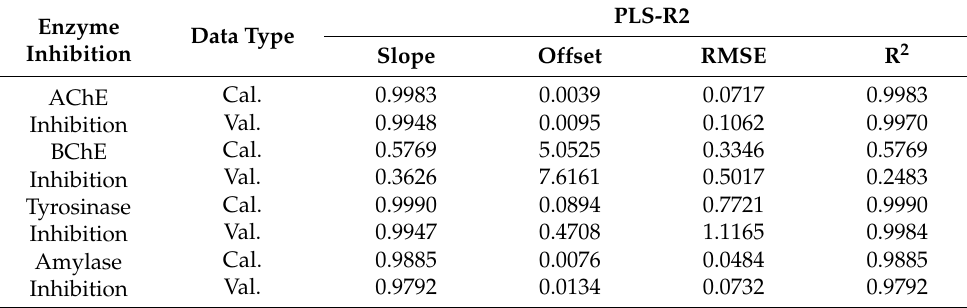
Table 6. PLS-R2 model parameters used for prediction.